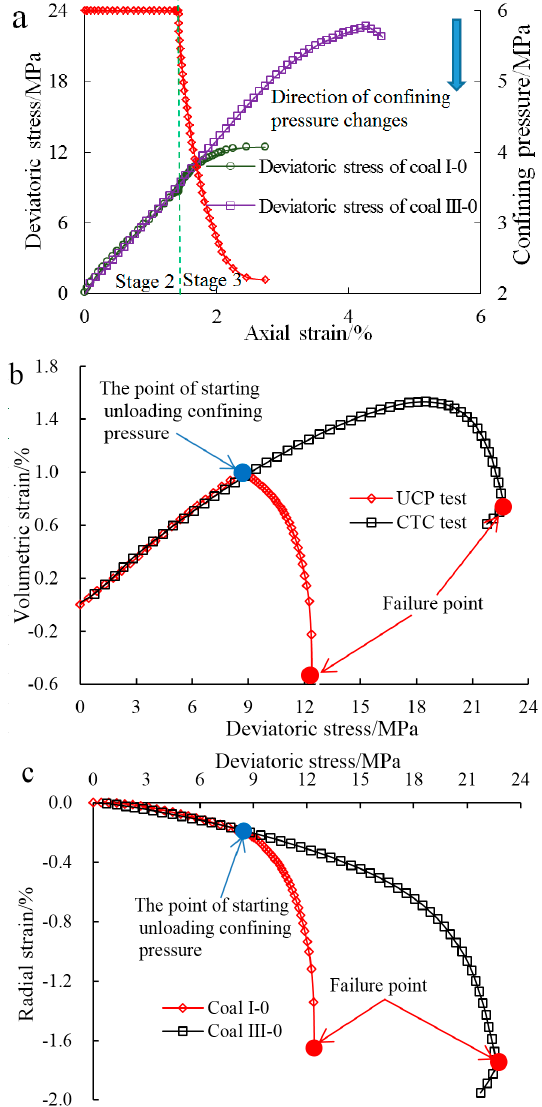
Figure 6. Stress–strain process of coal I-0 and coal III-0 (Stage 2 and Stage 3 in reference to Stress Path II): ( a ) stress vs. axial strain; ( b ) stress vs. volumetric strain; ( c ) stress vs. radial strain.